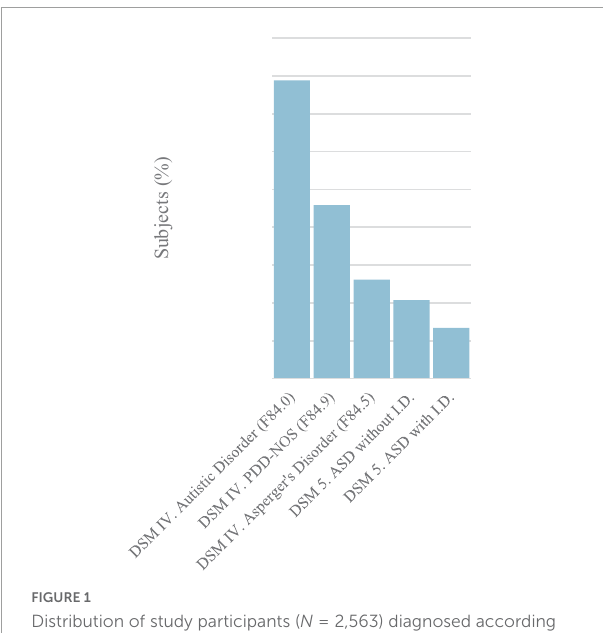
FIGURE1 Distribution of study participants ( N = 2,563) diagnosed according to DSM-IV or ICD-10 criteria for pervasive developmental disorder (PDD) and according to DSM 5 criteria for ASD. ASD, autism spectrum disorder; DSM-IV, American Psychiatric Association’s Diagnostic and Statistical Manual of Mental Disorders, Fourth Edition; DSM-5, American Psychiatric Association’s Diagnostic and Statistical Manual of Mental Disorders, Fifth Edition; ICD-10, International Classification of Diseases 10th